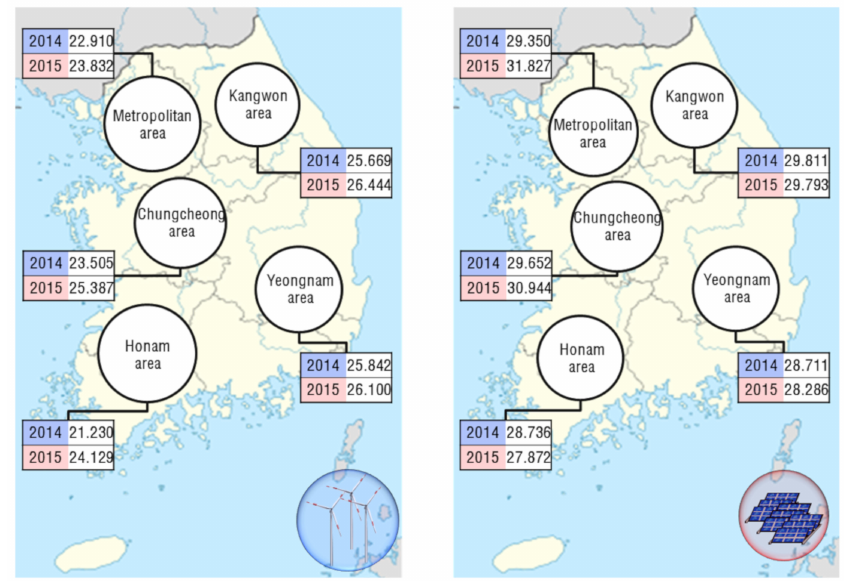
Figure A6. Average capacity factor for renewable energy in di ff erent areas [33].